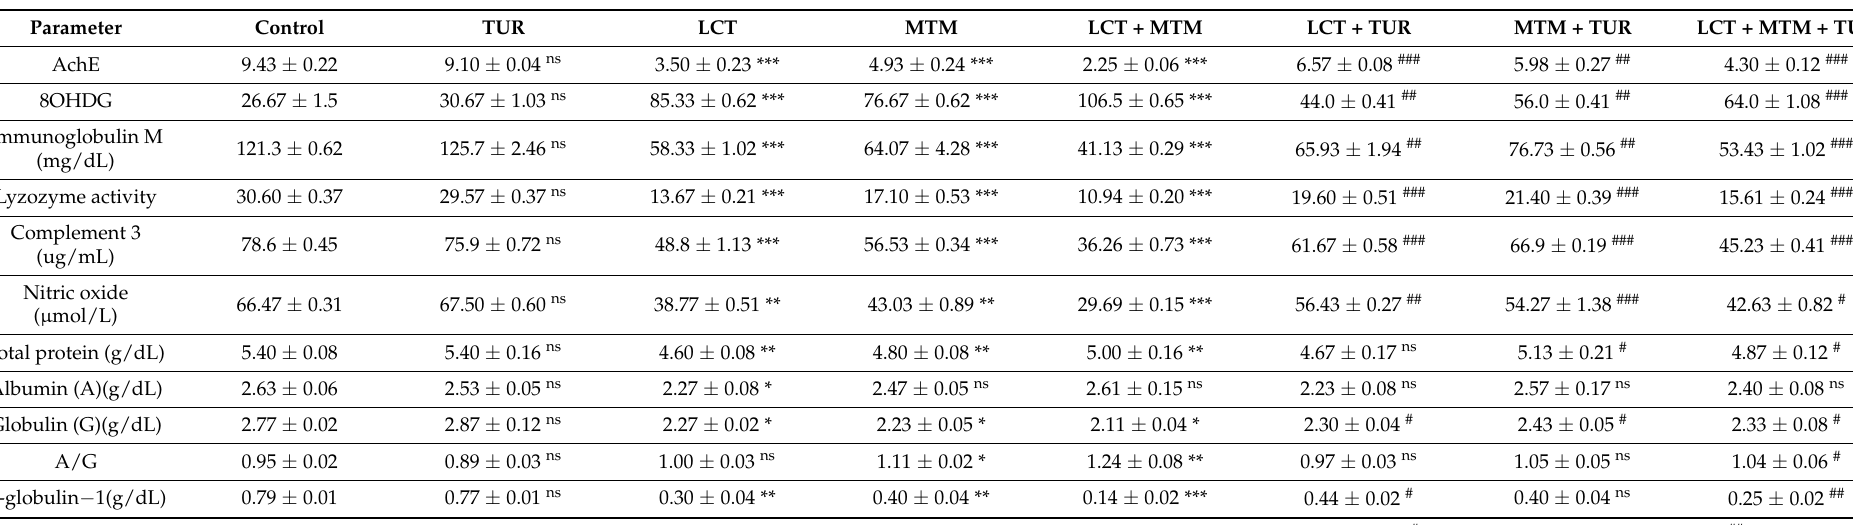
Table 5. Comparative and combined effects of LCT and MTM (1/20 of LC50) on AchE activity, OHDG, immunological indices, serum protein profile, mortality number, and percent post-infection for O. niloticus , and the role of taurine (1% in diet). Sixty days ( n =